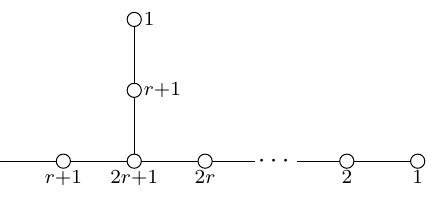
Figure 10. The magnetic quiver for the 5d SCFT with SO(4 r + 6) × U(1) global symmetry. The last quiver in figure 9 describes an SU(2 r + 1) gauging of two copies of this theory.